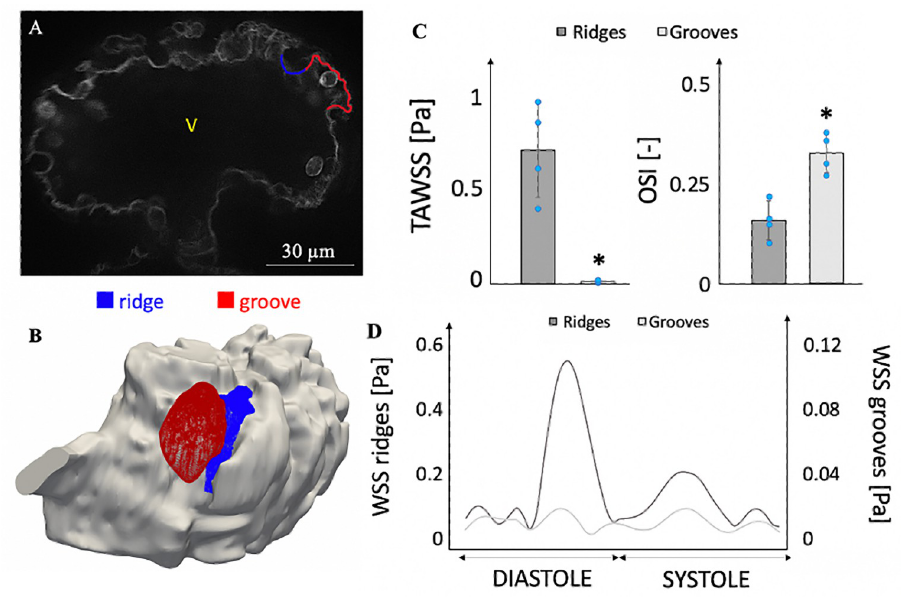
Fig 3. Comparison of area-averaged WSS, time- and area-averaged WSS and OSI for the ridges and grooves. (A, B) A typical intra-trabecular space (red) and the neighboring trabeculation ridge (blue) used for the WSS quantification and comparison. (C) Mean and standard deviation of the time-averaged WSS (TAWSS) and OSI (n = 4) with the mixed-viscosity assumption (viscosity of plasma for intra-trabecular spaces and the viscosity of blood for trabeculation ridges). Wilcoxon signed-rank test showed the lowest possible significance with the sample size (n = 4), p = 0.0625. (D) Temporal variation of WSS on a single ridge and groove under the same assumption.